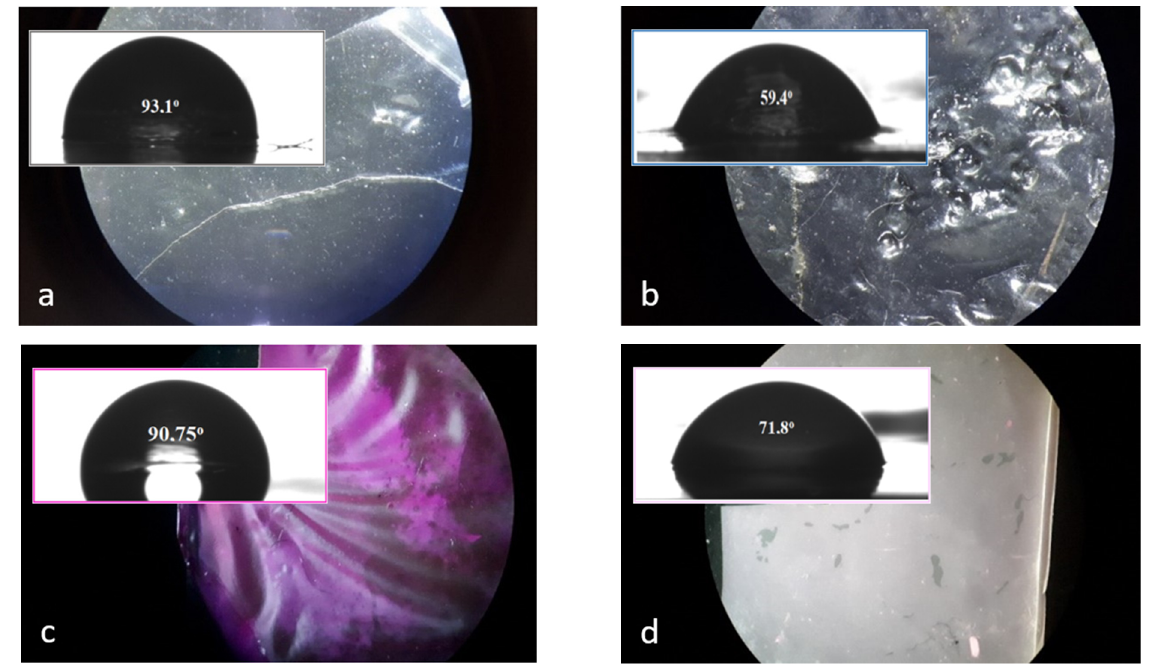
Figure 4. Stereoscopic microscope images and the values of the contact angle (deg) of the modified chitosan hydrogel films ( a ) CS; ( b ) CS/Gly; ( c ) CS/Rh B; and ( d ) CS/NPs Rh B.